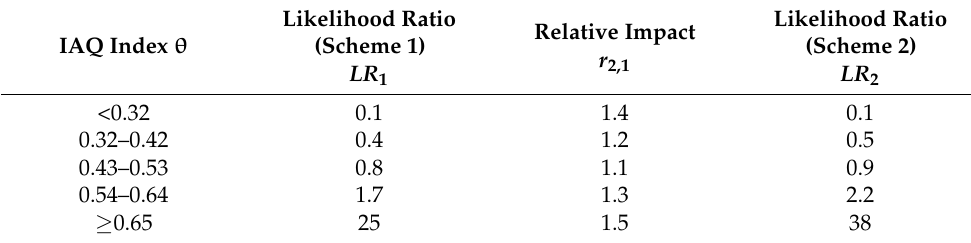
Table 6. IAQ index of air-conditioned offices in Hong